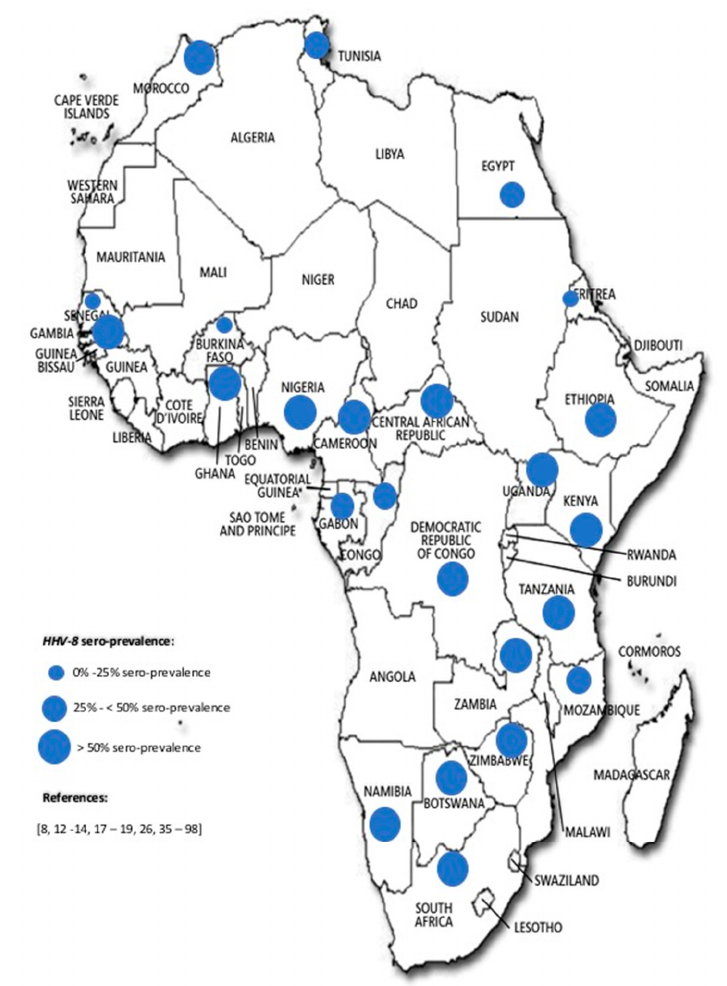
Figure 2. A representation of the highest HHV-8 seroprevalence observed in any one